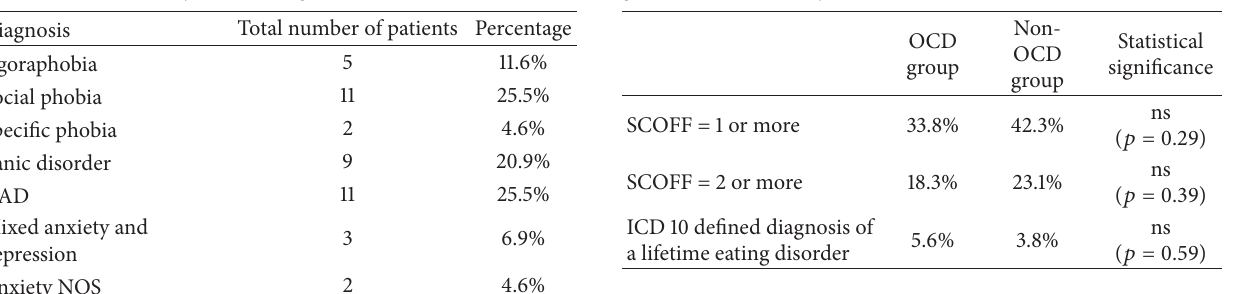
Table 2: Distribution of ICD 10 defined anxiety disorders in the non-OCD anxiety disorders group.